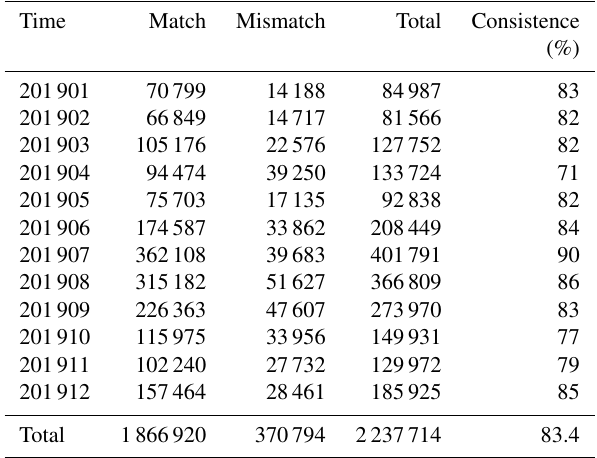
Table 5. Cross-satellite comparison between FY-3D and MODIS fire